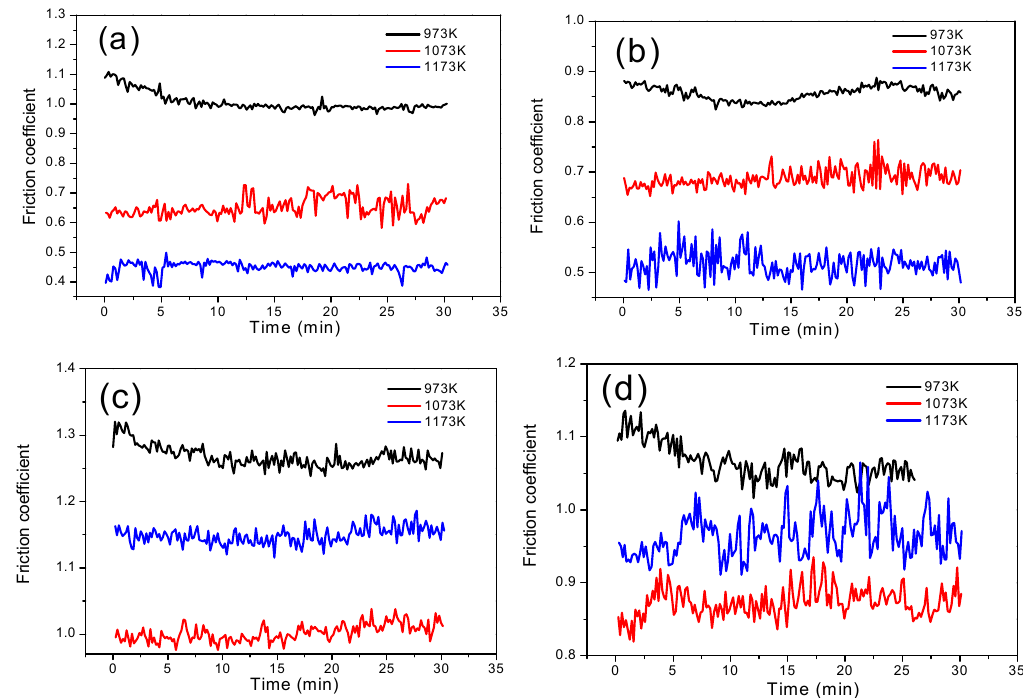
Figure 6. Friction coefficients of ( a ) 10Si-7B, ( b ) 12Si-8.5B, ( c ) 14Si-9.8B, and ( d ) 25Si-8.5B alloy doped with 0.3 wt % La 2 O 3 plate specimens sliding against Si 3 N 4 ball specimens in the temperature range of 973 to 1273 K.